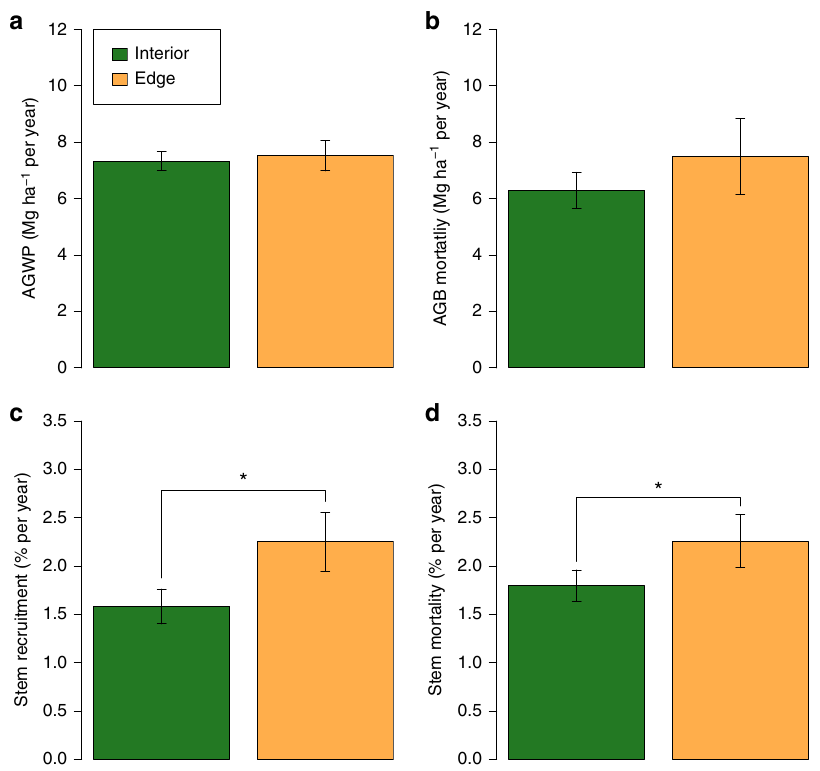
Fig. 4 Contrasting forest dynamics observed in forest interior and close to anthropogenic edges in Borneo. Above-ground wood productivity (AGWP, a ), Above-ground live biomass (AGB) mortality ( b ), stem recruitment ( c ) and mortality ( d ) rates are long-term means (mean monitoring period 1988 – 2010) estimated using linear mixed effects (LME) models. Bars are 95% CIs. Asterisks indicate signi fi cant difference (Stem mortality: P = 0.006; Stem recruitment: P < 0.001). Individual plot values for these variables are presented as histograms in Supplementary Fig. 5 showing variation in both interior and edge